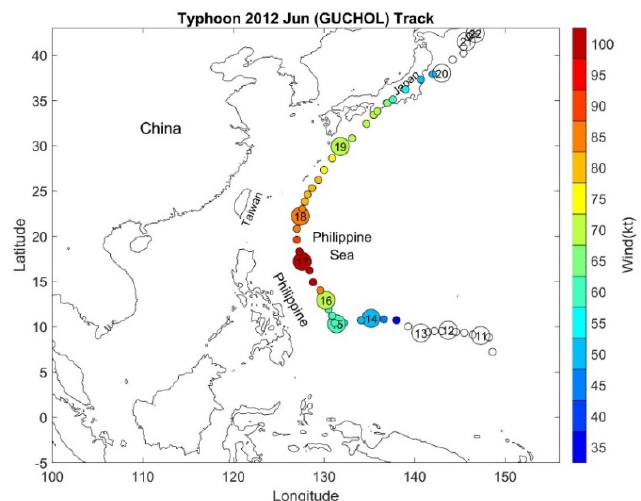
Figure 1. Geography of the Western Pacific Ocean and track of Super Typhoon Guchol (2012) with strength.